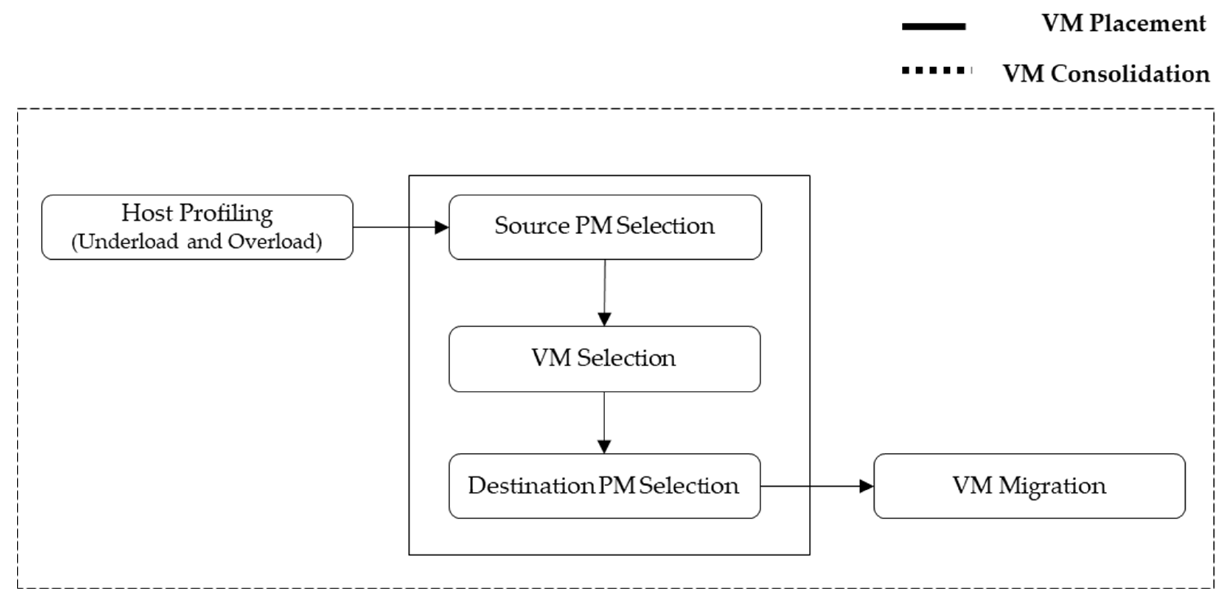
Figure 3. Virtual machine consolidation framework.